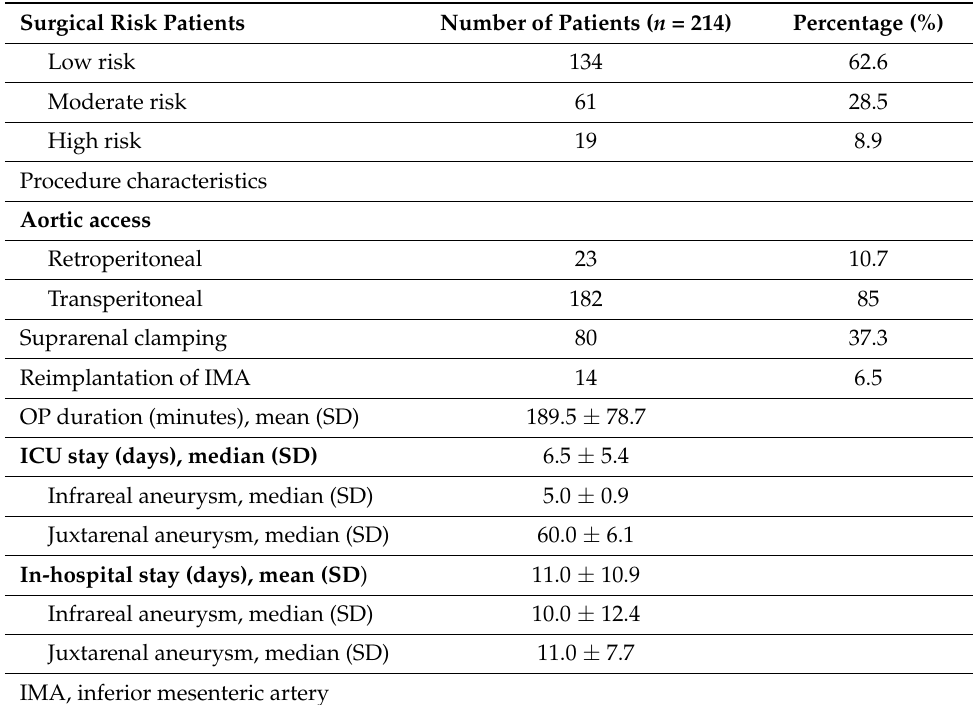
Table 3. Baseline characteristics and procedural